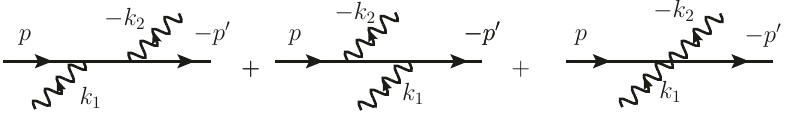
as incoming and − p 0 , − k as 1 2